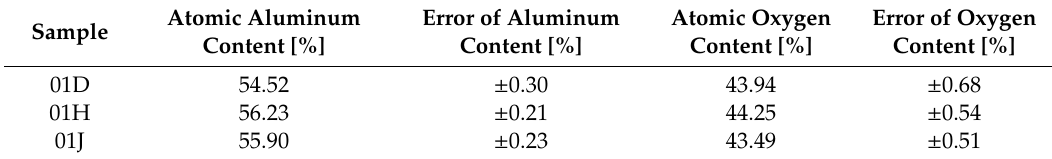
Table 11. Chemical composition analysis of Al 2 O 3 coatings without thermo-chemical